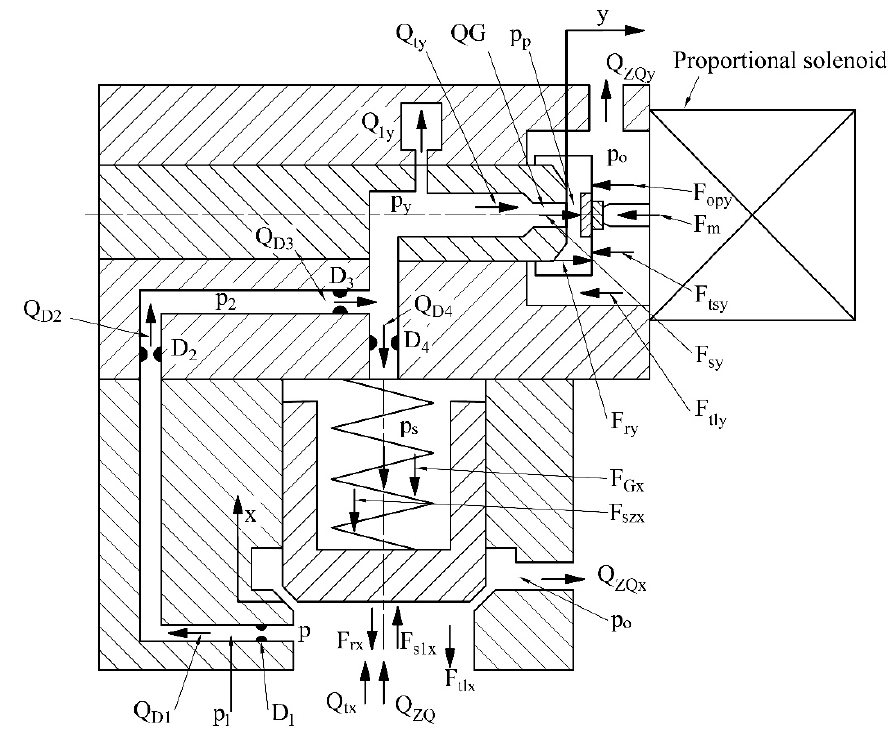
Figure 2. The tested two-stage proportional relief valve.